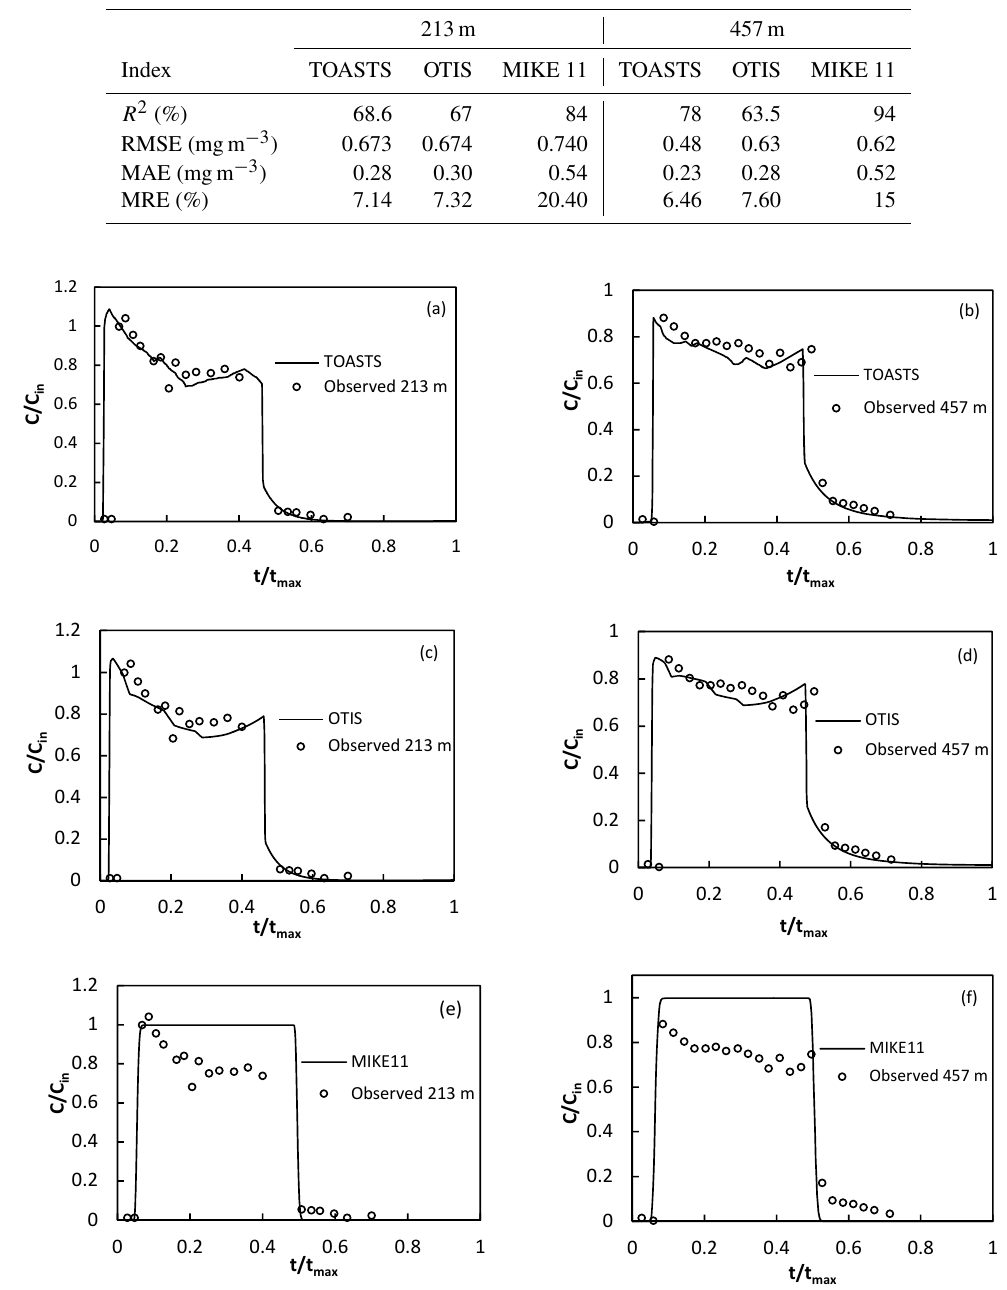
Figure 20. Observed and simulated main channel lithium concentrations (test case